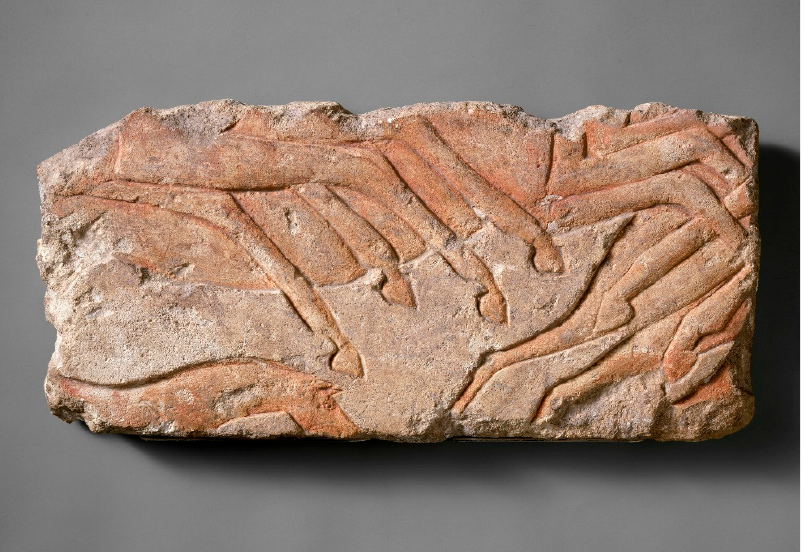
Figure 20. Group of galloping horses on a talatat from Amarna. Metropolitan Museum of Art, Gift of Norbert Schimmel, 1985. Inv. no. 1985.328.17.